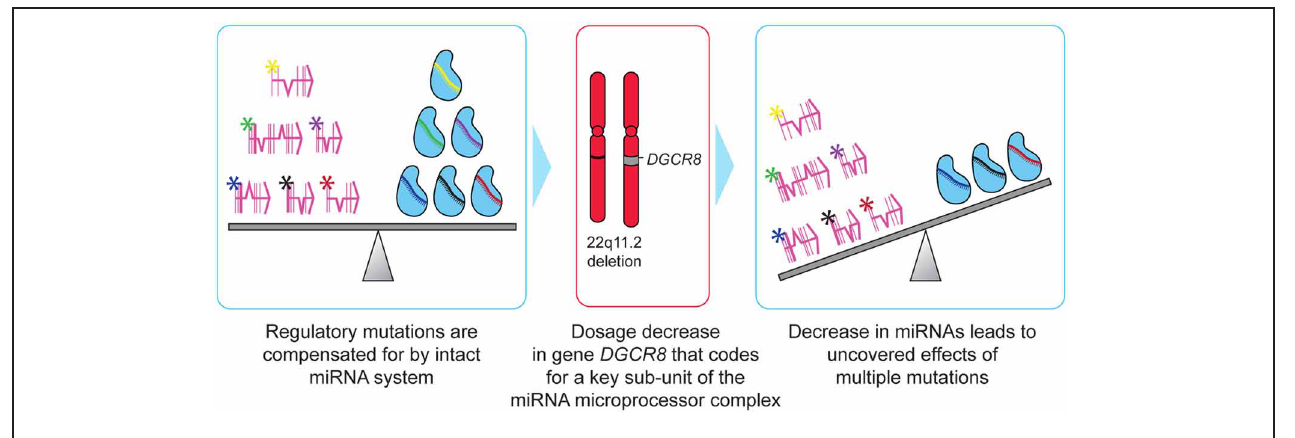
FIGURE 2 | Two-hit model of schizophrenia in 22q11.2DS. Mutations that are compensated for by an intact miRNA regulatory system can silently accumulate within individuals, with little selective pressure acting to remove them from the population. Deletion of 22q11.2 results in haploinsufficiency of